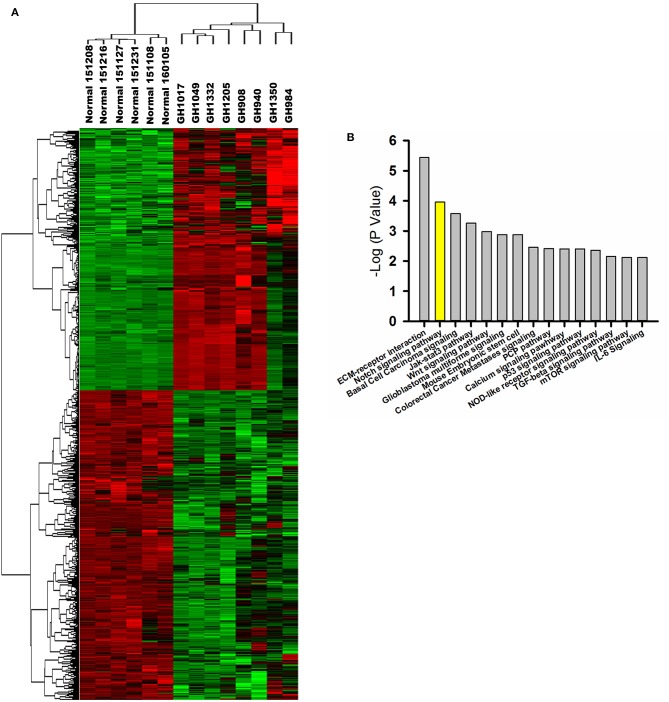
Gene expression profiling and proteomics analysis. (A) A heatmap of differentially expressed mRNAs (FC > 2 and FDR q< 0.1) between GHoma and normal pituitary tissue analyzed by hierarchical clustering. Each row represents a single mRNA. Each column represents an individual sample. High expression was shown in red; low expression was shown in green. (B) The top 15 canonical pathways from proteomics and transcriptome were shown.